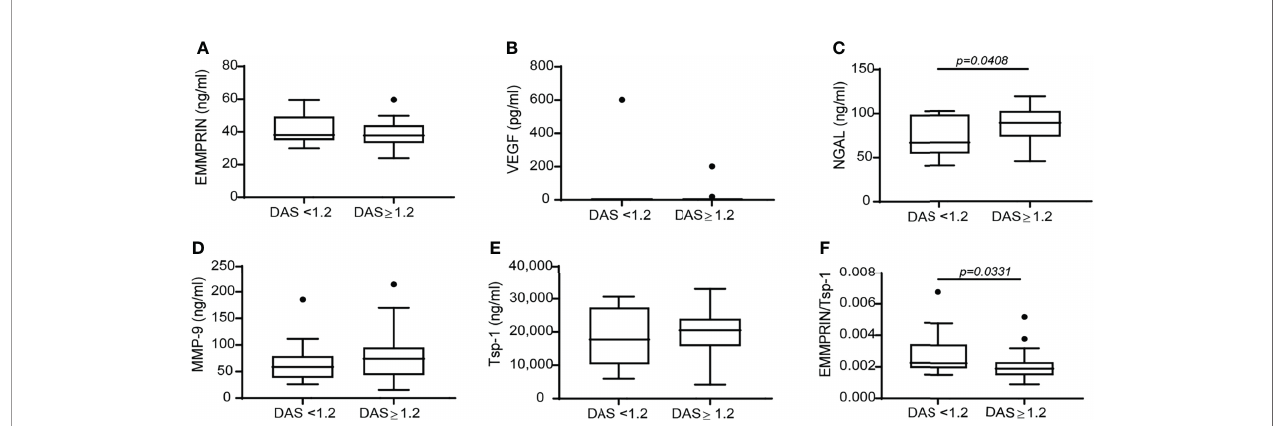
FIGURE 2 | The change in the disease activity score DAS28 is not associated with a difference in the concentration of angiogenic factors, except for the ratio EMMPRIN/Tsp-1. Patients were strati fi ed into responders and non-responders according to the change in their DAS28 score to assess the effects of TCZ on the concentrations of the angiogenic factors. (A) EMMPRIN, (B) VEGF, (C) NGAL, (D) MMP-9, (E) Tsp-1, and (F) the ratio between EMMPRIN and Tsp-1 as a suggested measure of enhanced angiogenesis. The non-parametric Mann-Whitney test was used to compare between the concentrations of each of the cytokines before and 4 months after TCZ treatment (n=40).